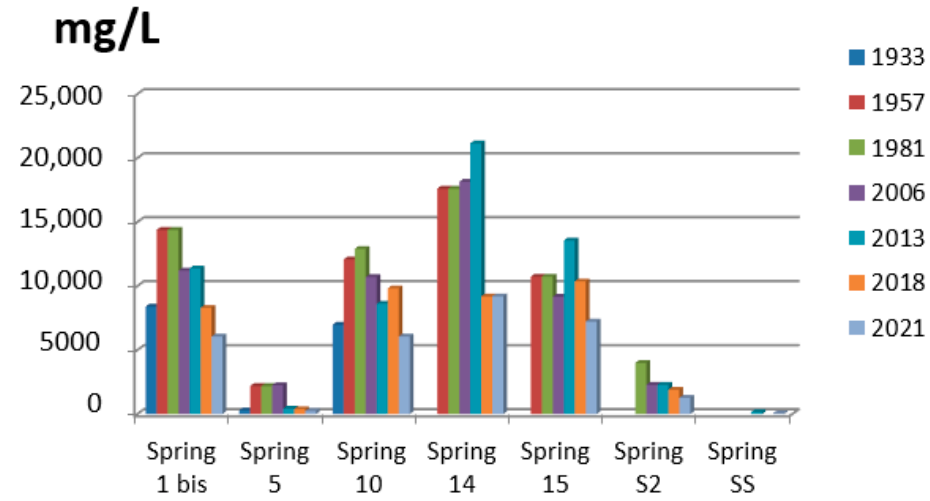
Figure 2. Variation of water mineralization from Slanic Moldova from 1933–2021.